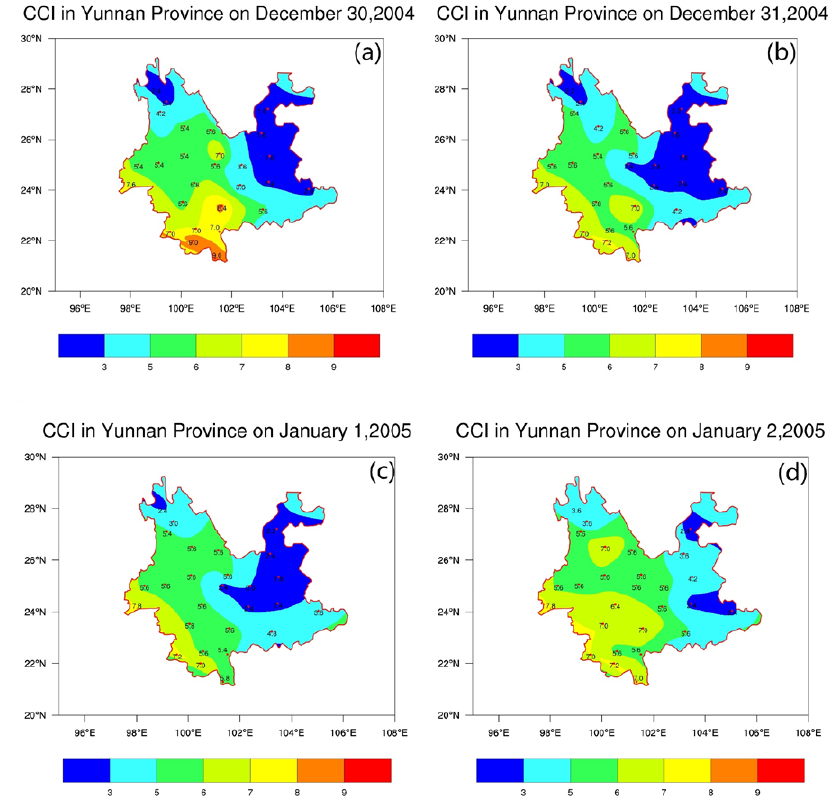
Figure 10. CCI distributions for Yunnan between 30 December 2004 and 2 January